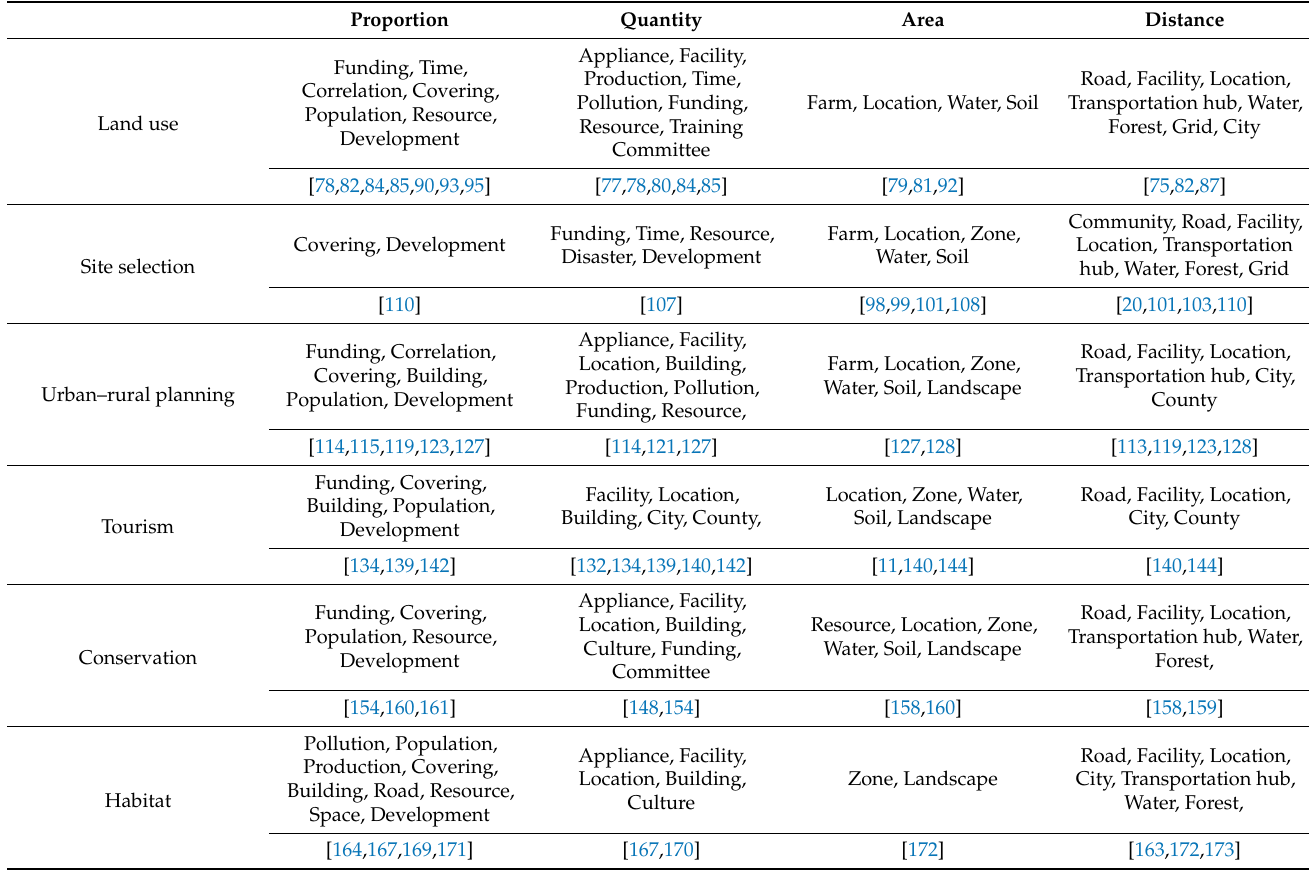
Table 7. Summary of index content.